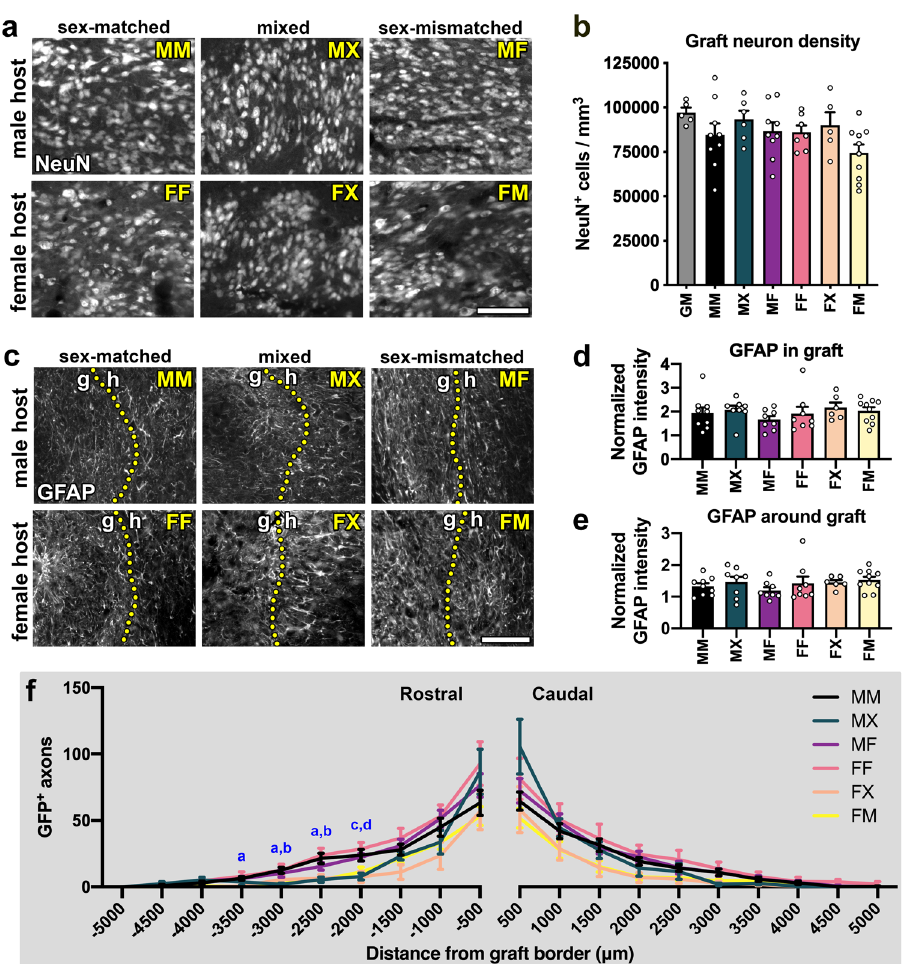
Fig. 2 | Graft type does not signi fi cantly in fl uence neuronal or glial differ- entiation. a Representative images of graft-derived neurons (NeuN). b Quanti fi cation of graft neuron density in each experimental group and intact spinal cord gray matter (GM). * P <0.05 vs. GM by ordinary one-way ANOVA with Dunnett ’ s multiple comparisons test. Statistical analysis details are in Supplemen- tary Table 1. GM ( n =5 mice), MM( n =9 mice),MX ( n =6 mice), MF( n =9 mice), FF ( n =7 mice), FX ( n =5 mice); FM ( n =10 mice). c Representative images of GFAP immunoreactivity in and around grafts. Dotted lines indicate the boundary betweengraft( g )andhost( h )tissue. d , e Quanti fi cationofGFAPimmunoreactivity ( d ) within the graft and e within a 250- μ m interval of host tissue immediately surrounding the graft; data are normalized to GFAP intensity in intact spinal cord gray matter. No signi fi cant differences were detected by two-way ANOVA with